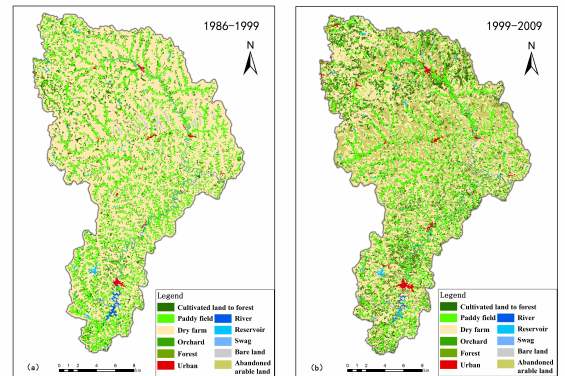
Figure 5 Geospatial distributions of conversions from cultivated land to forest in different study